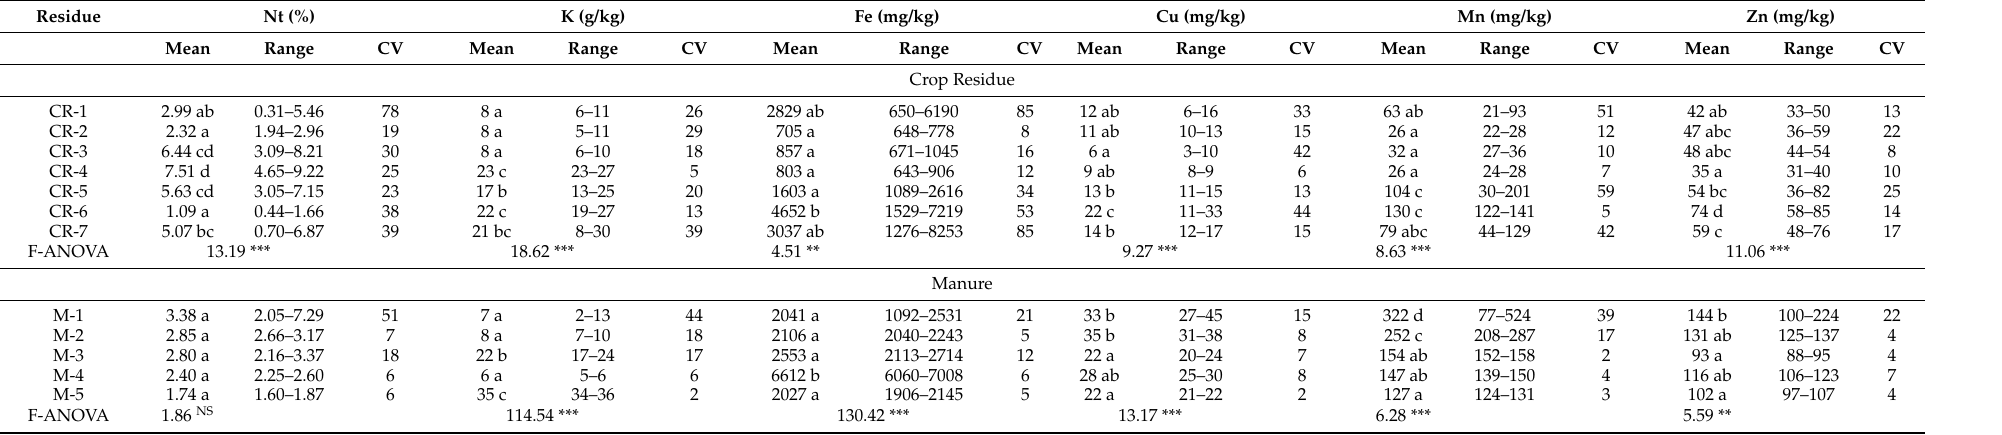
Table 4. Macro and micronutrient contents (on a dry weight basis) of the agro-livestock